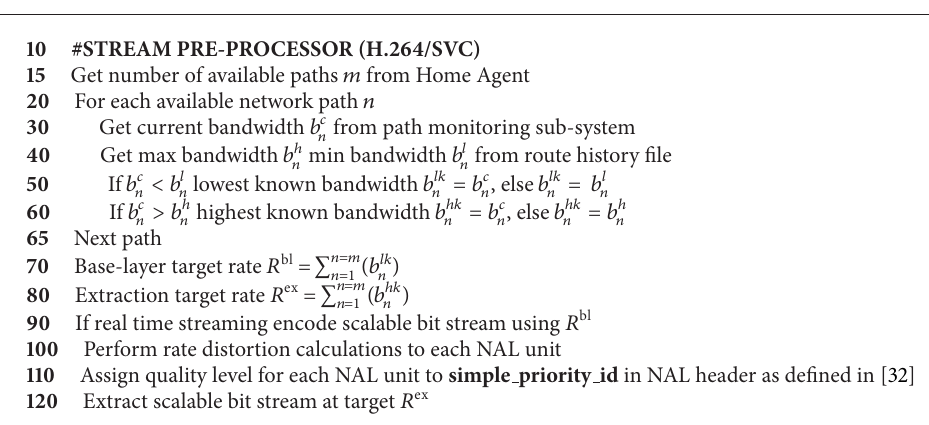
Algorithm 1: Stream preprocessing algorithm (H.264/SVC version).